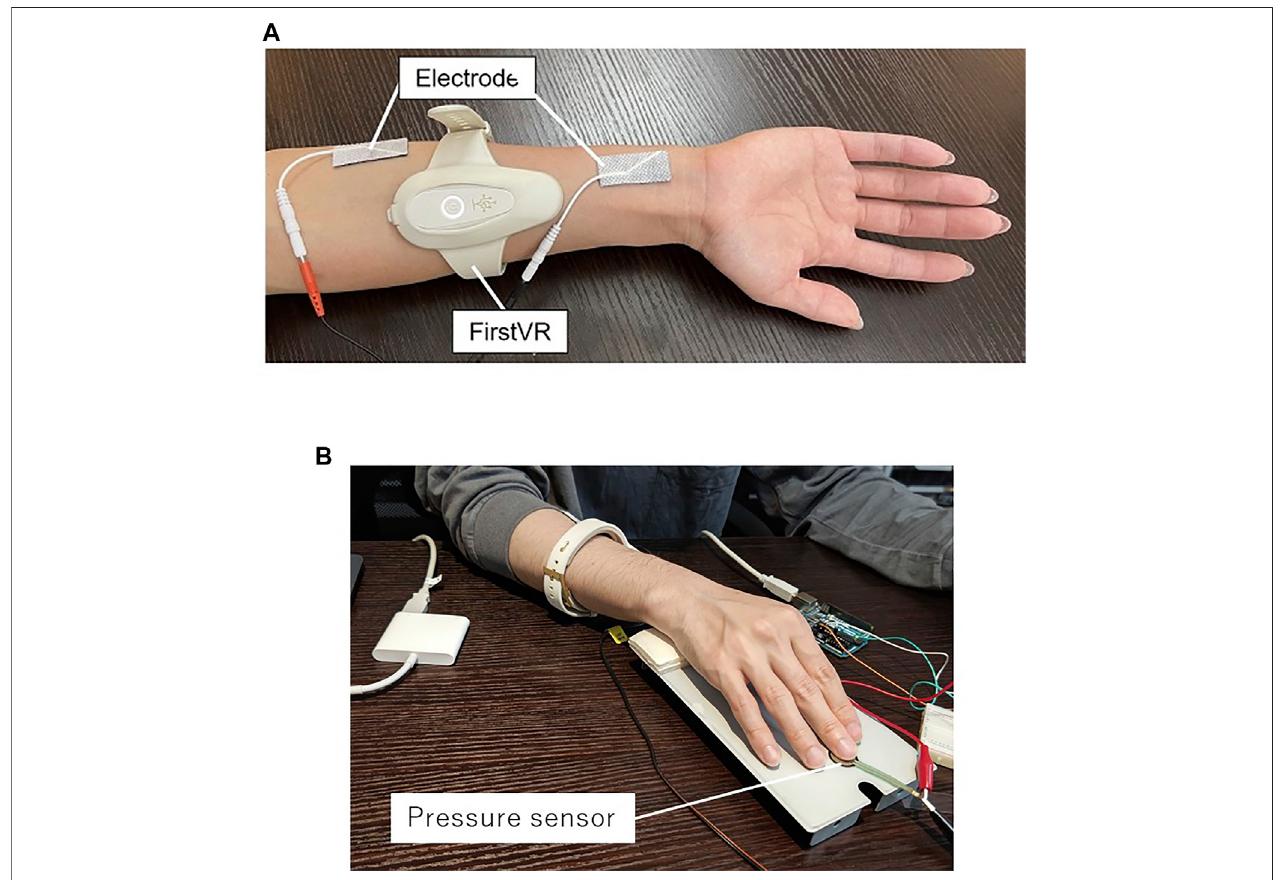
FIGURE 3 | Experiment images. (A) Arrangement of electrodes and FirstVR. (B) Scene of the experiment.